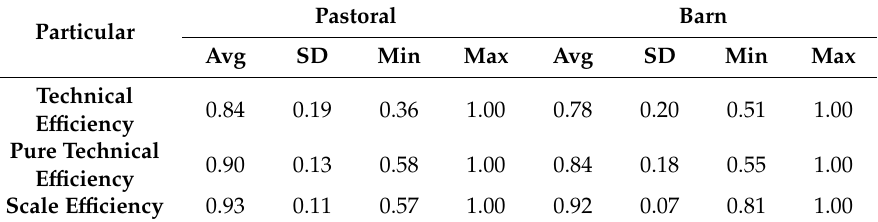
Table 3. Technical, pure technical and scale e ffi ciencies of PDFs and BDFs Systems (50 DMU’s).